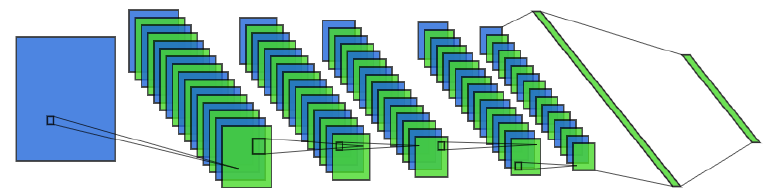
Figure 4. The architecture of the discriminative model.